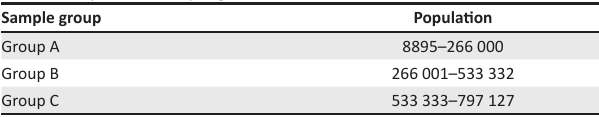
TABLE 4: Population sampling. Sample group